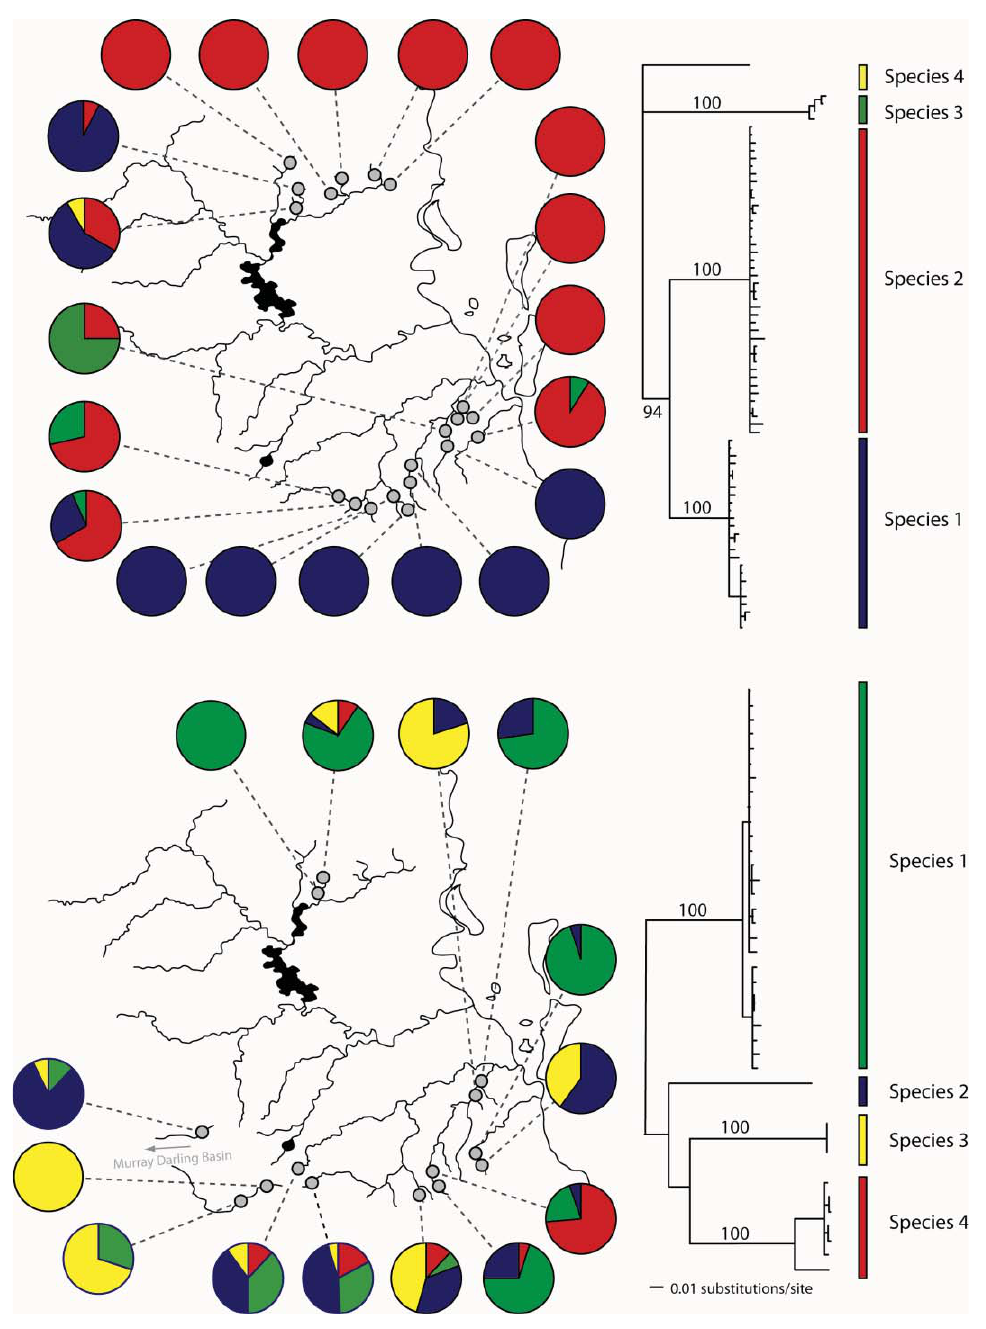
Figure 4. Phylogenies for two ephemeropteran taxa, Altophlebia spp. (top) and Bungona narilla (bottom), and the geographic distributions of cryptic species. The sampled region is identical to Figure